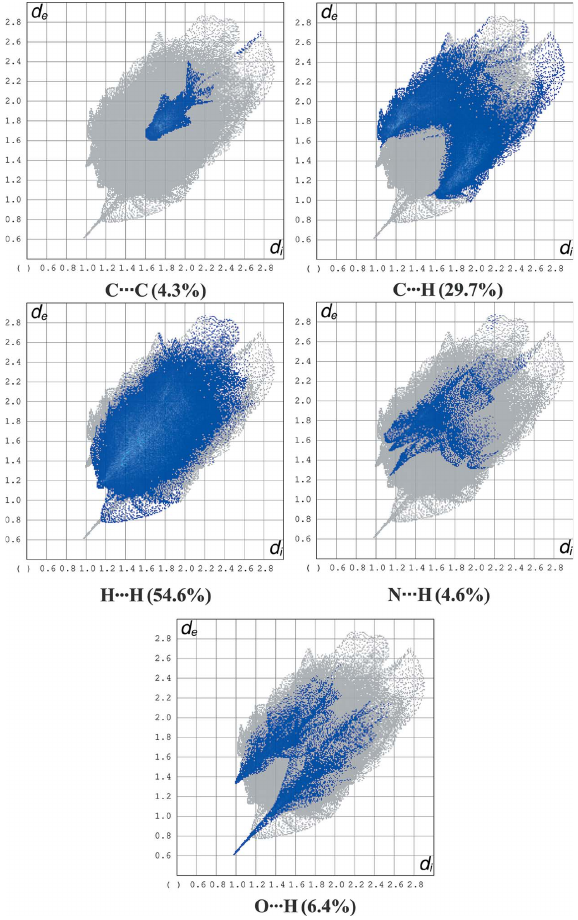
Figure 4 The two-dimensional fingerprint plots for compound 2 .